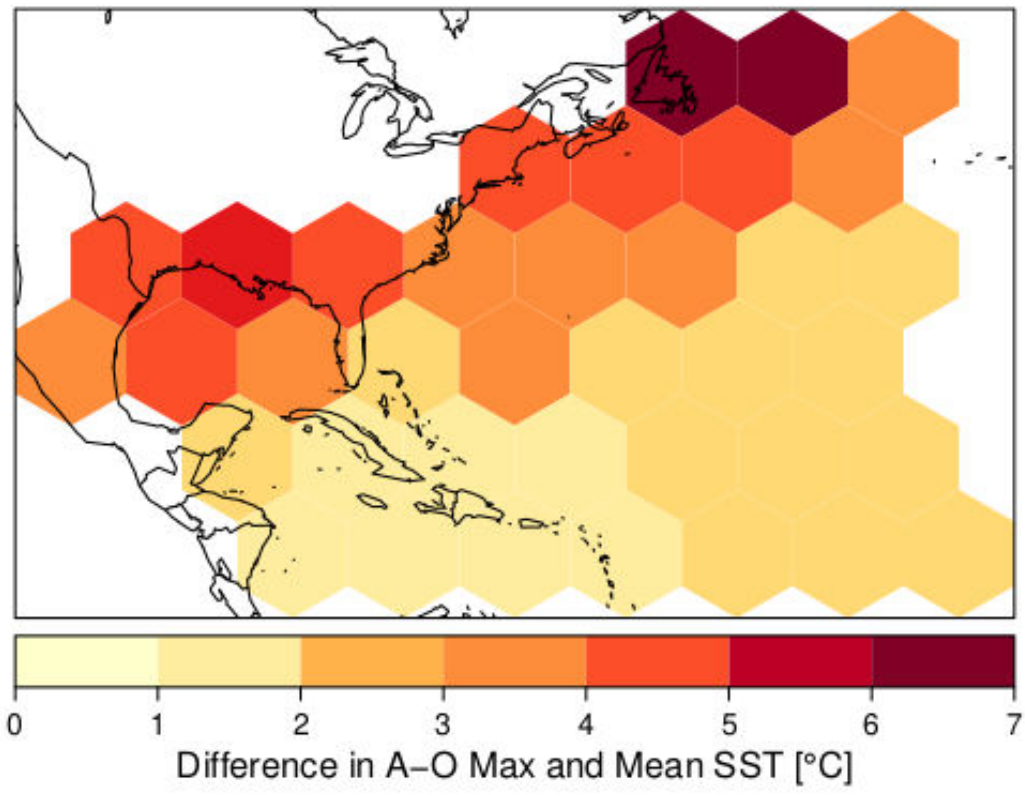
Figure 4. Difference between mean August–October sea surface temperatures (SST) ( ◦ C) and maximum August–October SST ( ◦